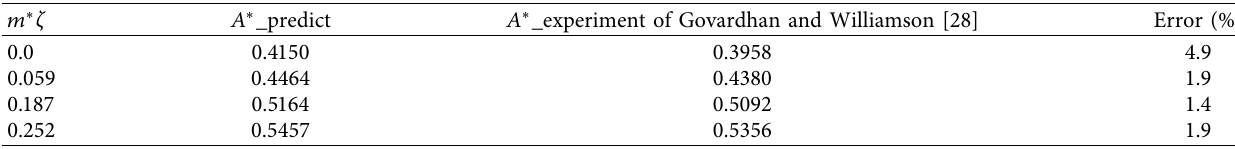
Table 5: Comparison of A ∗ at λ ∗ � 6 . 2 with experiment results.